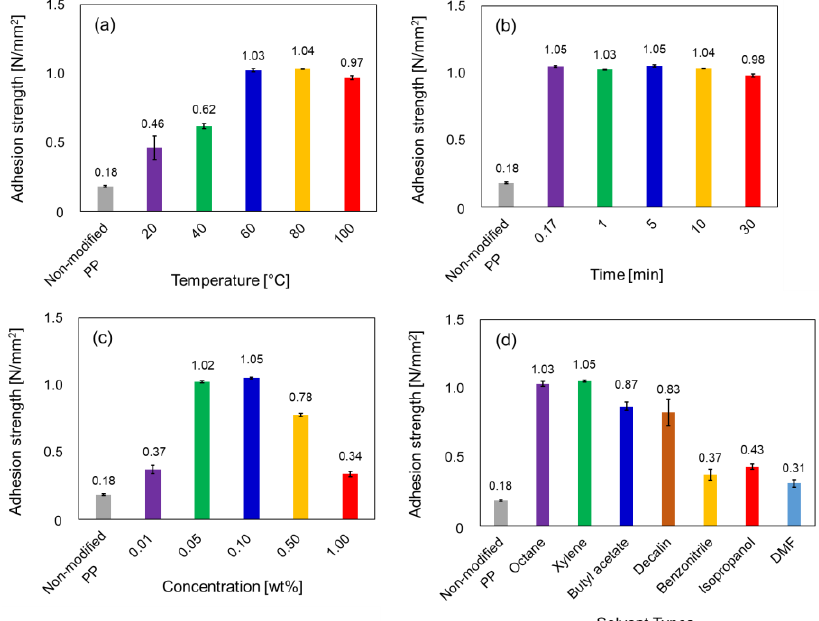
Figure 3. Adhesion strength of the non-modified PP and PP modified with the SCCBC evaluated by the tensile shear tests: ( a ) 0.1 wt% of BHA-TBAEMA in xylene for 10 min at different dipping temperatures; ( b ) 0.1 wt% of BHA-TBAEMA in xylene at 80 °C with different dipping times; ( c ) BHA-TBAEMA at 80 °C for 5 min at different concentrations of BHA-TBAEMA in xylene solution; ( d ) 0.1 wt% of BHA-TBAEMA in different solvent types at 80 °C for 5 min.